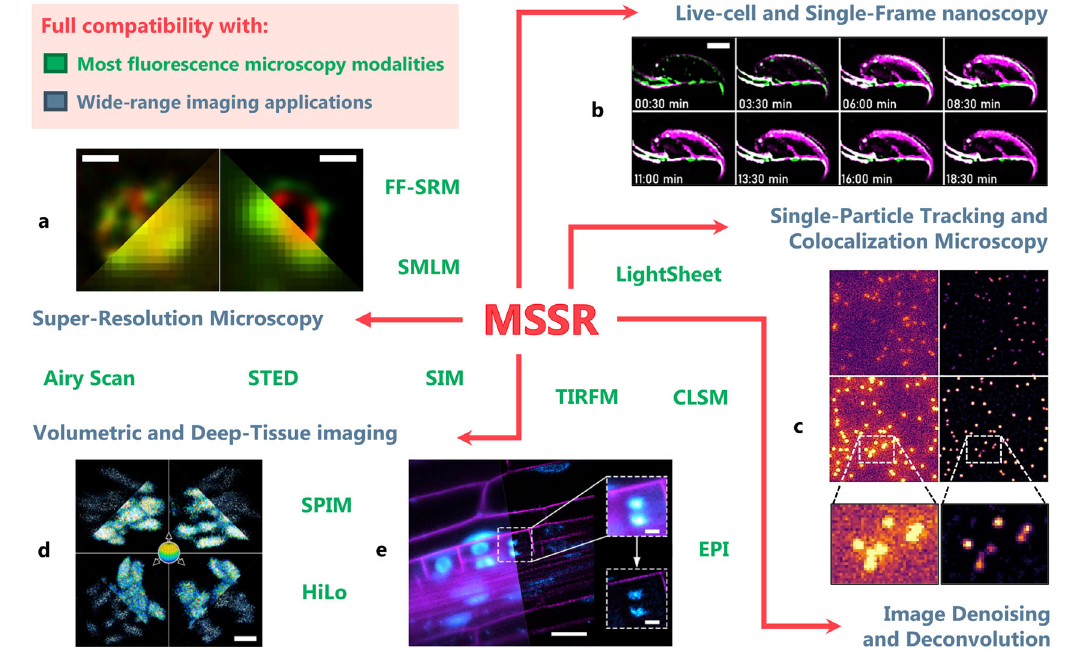
Fig. 9 | MSSR applications in fl uorescence microscopy. MSSR operates over images acquired with most fl uorescence microscopy modalities available (e.g., wide fi eld,confocal,light-sheet,etc.),denotedbythetextingreen.Itcanbeapplied toachieveenhancedimageresolution,SNRandcontrastinlive-cellimaging,single- particle tracking, deep tissue and volumetric imaging, among others (denoted by thetextinpaleblue).Someexamplesoftheseapplicationsaredetailedinthemain text and Supplementary Note 10. FF-SRM Fluorescence Fluctuation-based